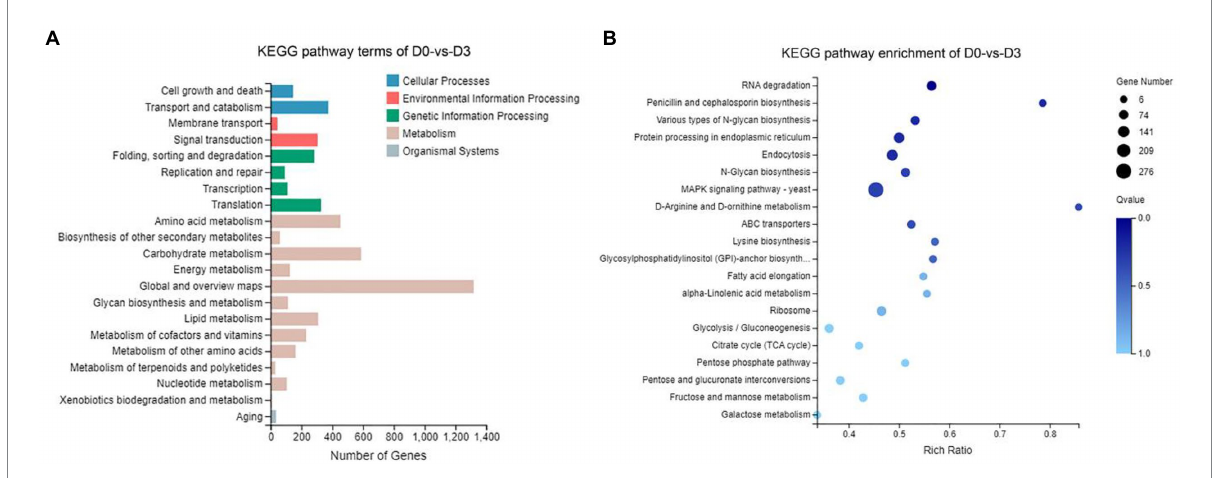
FIGURE 9 KEGG analysis of DEGs during the fermentation of D0- vs -D3. (A) The KEGG pathway terms analysis and (B) KEGG pathway enrichment analysis of top 20 with the smallest Q